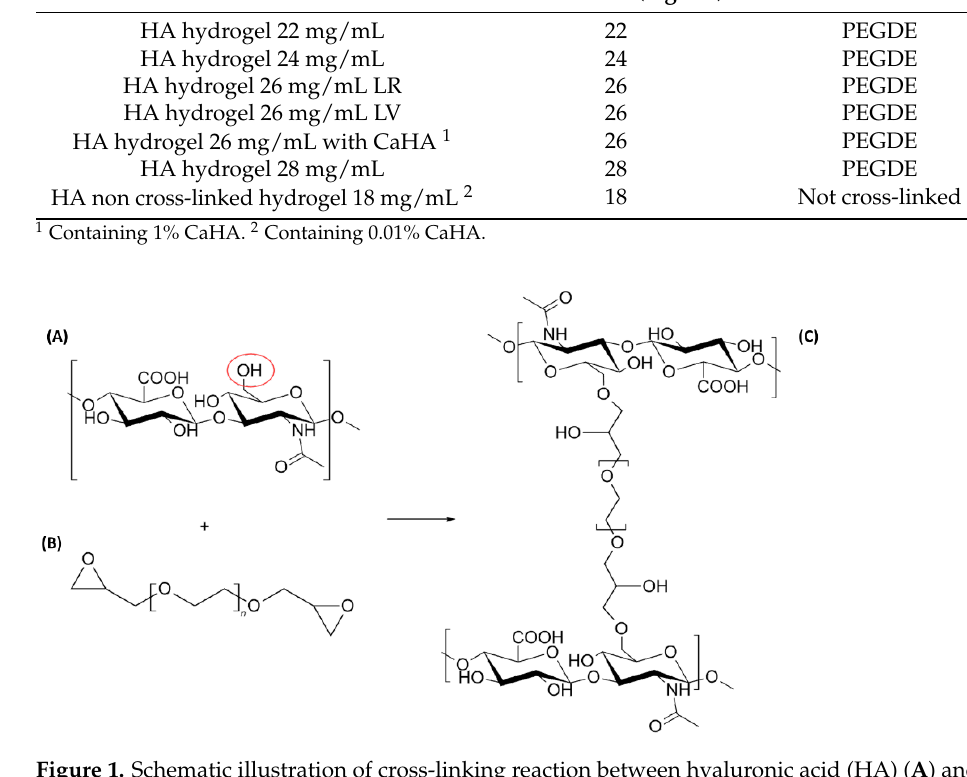
Figure 1. Schematic illustration of cross-linking reaction between hyaluronic acid (HA) ( A ) and the (polyethylene glycol diglycidyl ether) PEGDE cross-linking agent ( B ). The chemical process occurs in alkaline conditions with ether bond formation ( C ). Image obtained with ChemSketch 2020.1.2 (Advanced Chemistry Development, Inc., Toronto, ON, Canada).